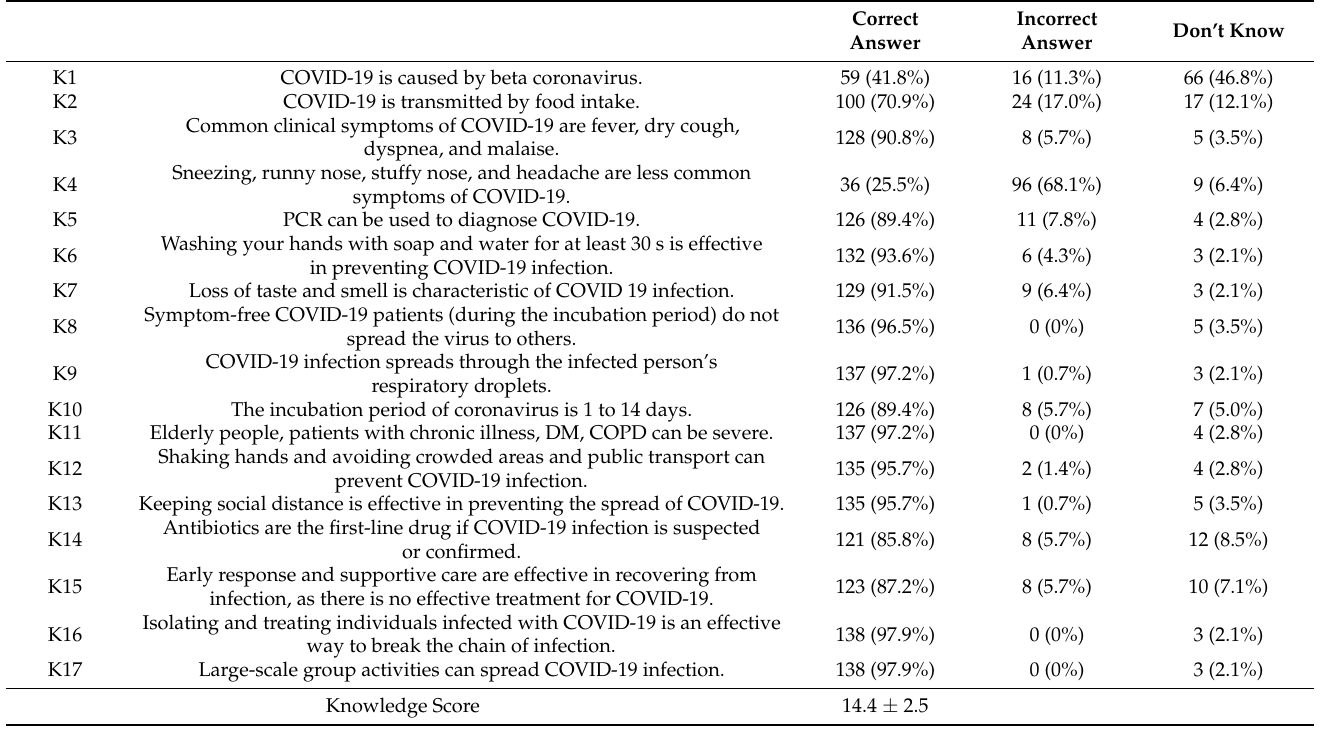
Table 2. Respondents’ answers on COVID-19 knowledge items.